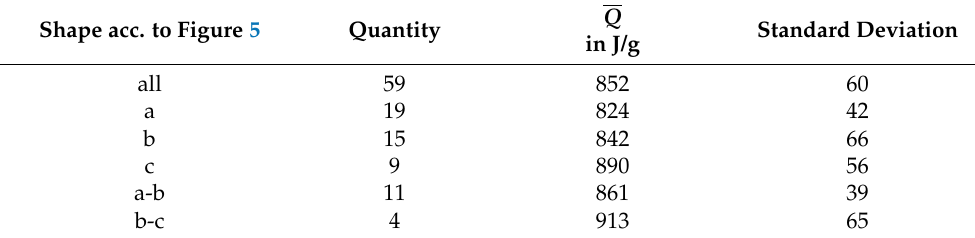
Table 2. Mean heat of reaction depending on the shape of the measurement curve. Shape acc. to Figure 5